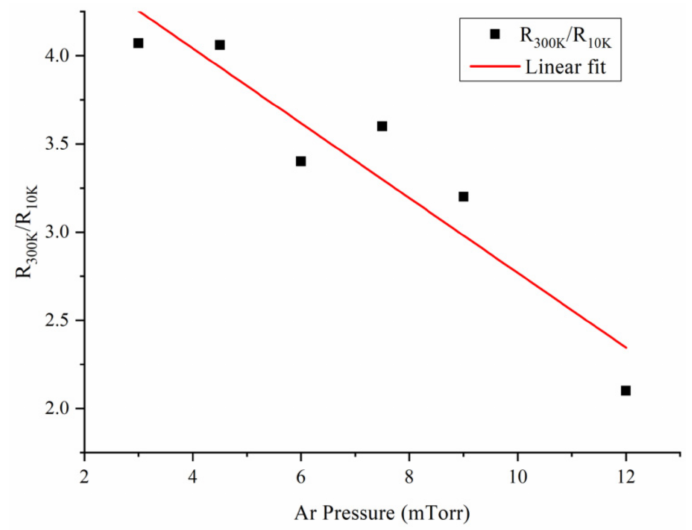
Figure 3. The residual resistance ratio of Nb films versus Ar